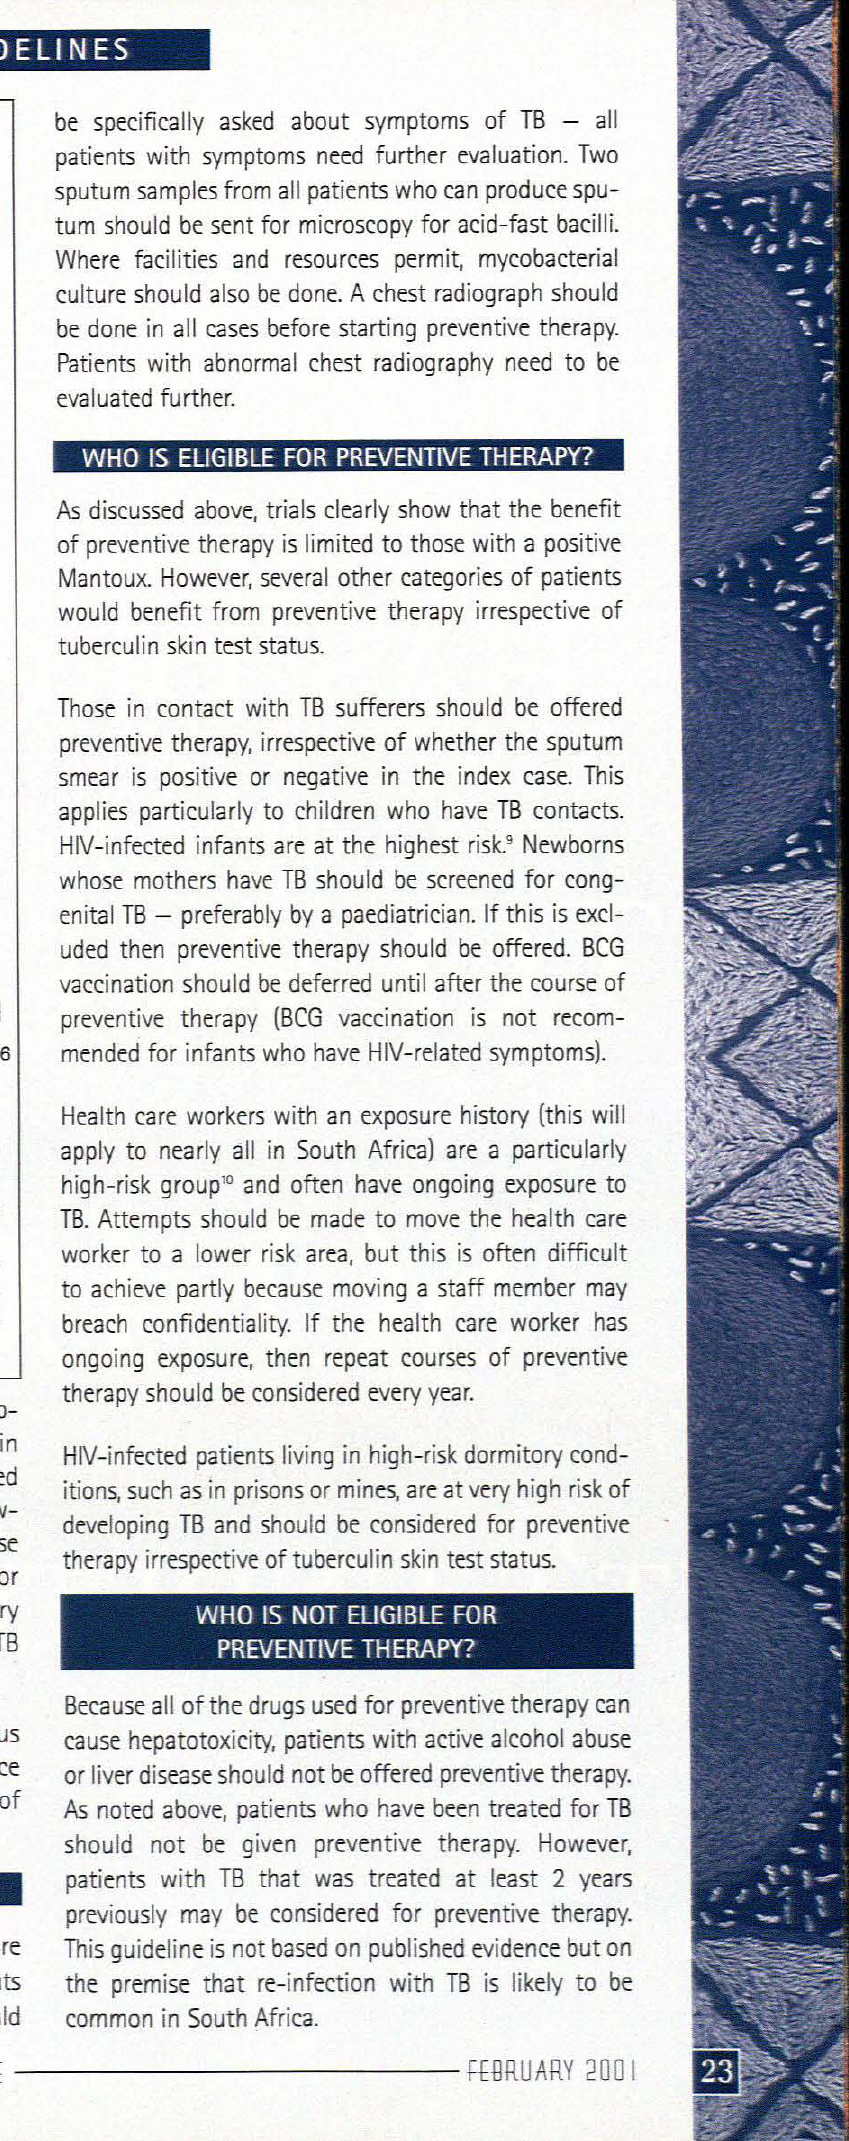
Preventive therapy is well tolerated, with few serious adverse events reported in clinical trials. Compliance in clinical trials as well as in the field is in the range of 60 -